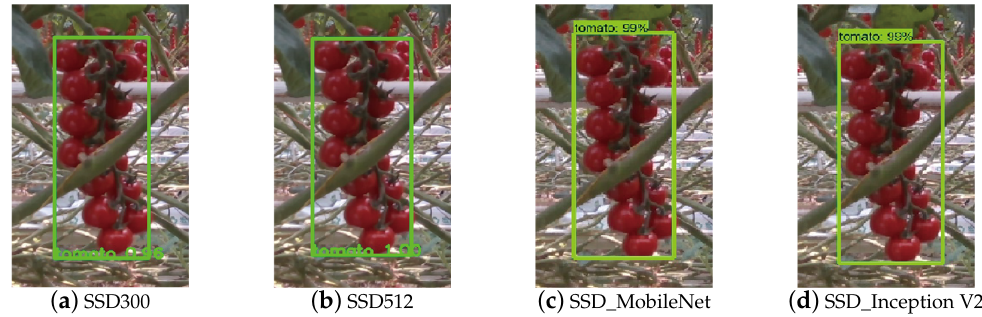
Figure 6. The detection results of obscured cherry tomatoes. ( a ) the result of SSD300 model, ( b ) the result of SSD512 model, ( c ) the result of SSD_MobileNet model and ( d ) the result of SSD_Inception V2 model.